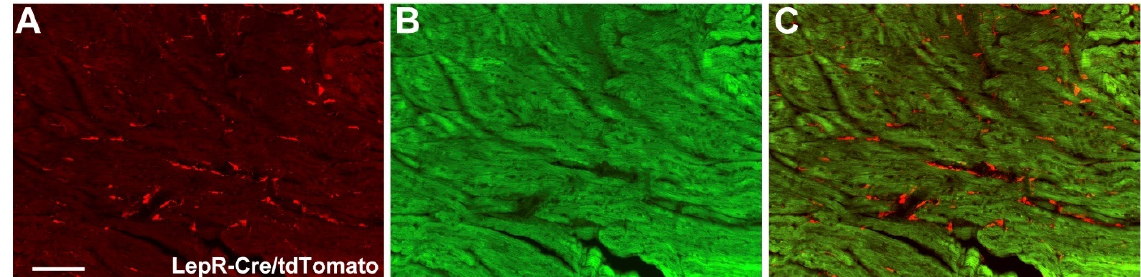
Figure 5. LepRb is not expressed in cardiomyocytes. ( A – C ) Epifluorescence photomicrographs showing the expression of tdTomato protein (red straining) in the heart of a LepR-reporter mouse. Note that tdTomato is expressed in the tissue matrix, but not in cardiomyocytes. Scale bar = 100 µm.